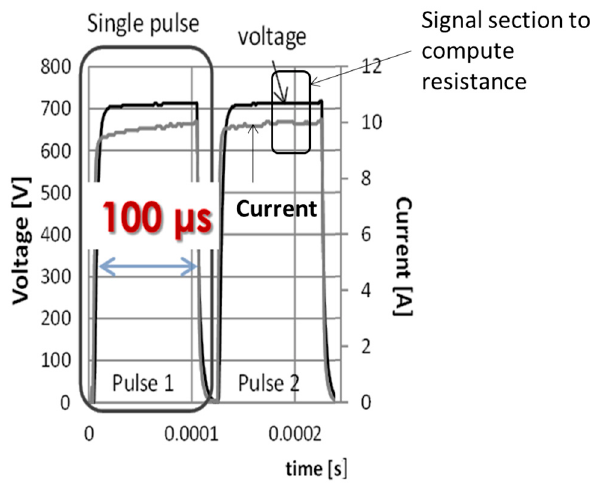
Figure 3. Voltage pulse shape applied and the resultant current pulse for the evaluation of the conductivity. (Note: only the positive part of the pulse is recorded. The 0 V part of the pulse is omitted to reduce memory space).